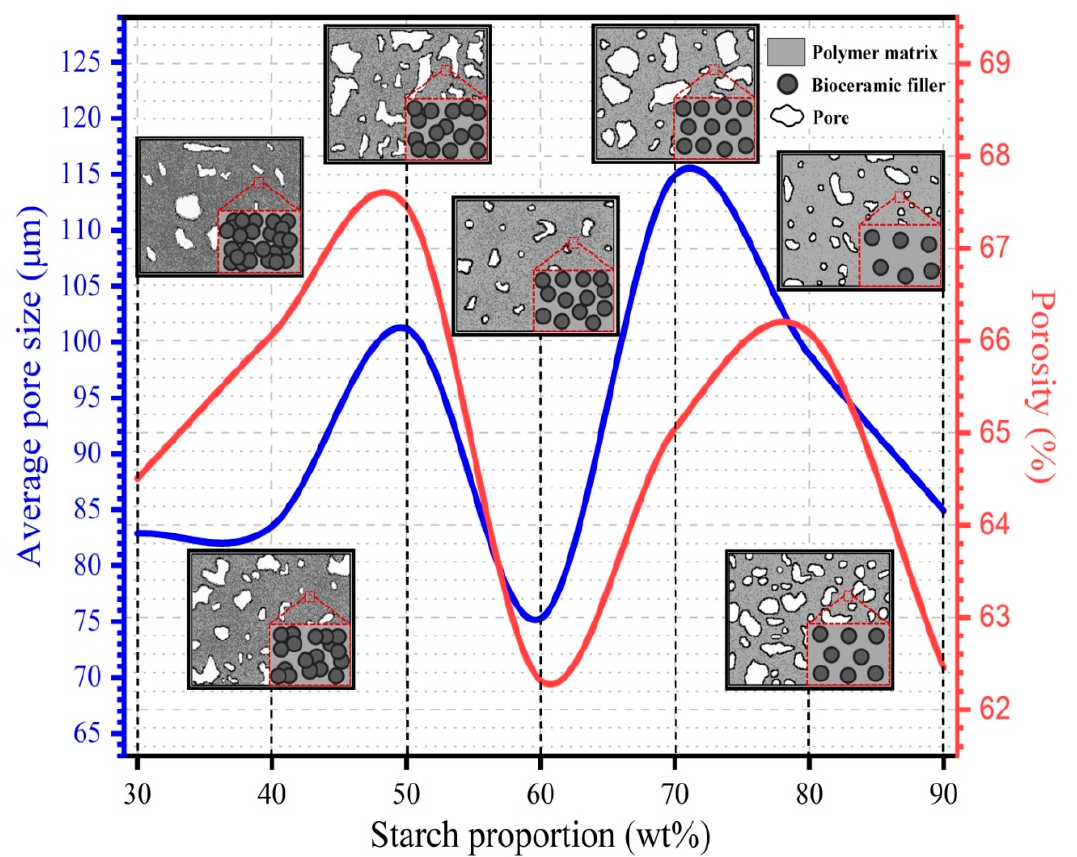
Figure 2. The effect of starch proportion on average pore size and porosity of the porous nHA/S composites.